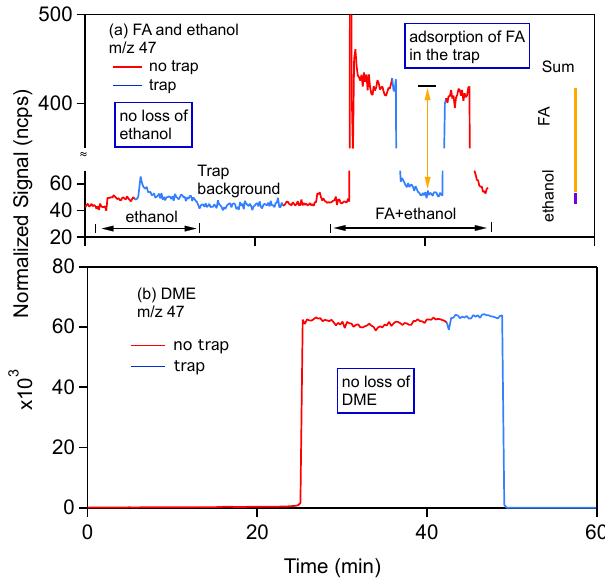
Figure 9. Separation of isobaric species detected at m/z 47 in the laboratory using the acid trap. Shown are (a) FA and ethanol and (b) DME. Formic acid is quantitatively retained in the trap, while DME and ethanol are